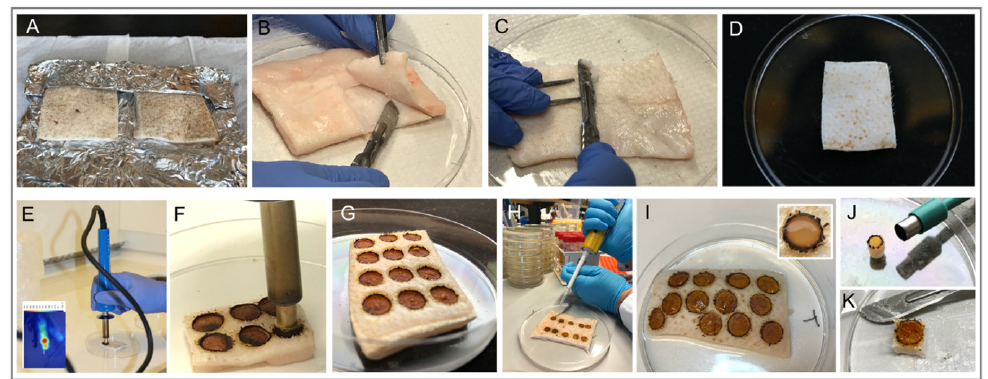
Figure 2. Photographs of the ex vivo wound model during the various procedural steps. ( A ) Fro- zen pig skin grafts left to defrost on the aluminum foil packaging for 2 h before continued han- dling. ( B ) Excess fat being separated and removed from the skin using a scalpel. ( C , D ) Residual fat remaining on the skin being removed by scraping with a scalpel, creating a homogenous tissue thickness and preventing potential bulging regions on the skin. ( E , F , G ) The soldering iron with a Ø 8 mm tip being placed against the skin for 15 s, creating uniformly sized wounds. ( H ) Bacterial solution being added to each of the wounds using a pipette. ( I ) Infected wounds immediately after application of antibacterial treatments. ( J ) Wound tissue collected using biopsy punch. ( K ) A piece of wound tissue cut out from the skin using a scalpel at the end of the experiment prior to prepa- ration for various downstream